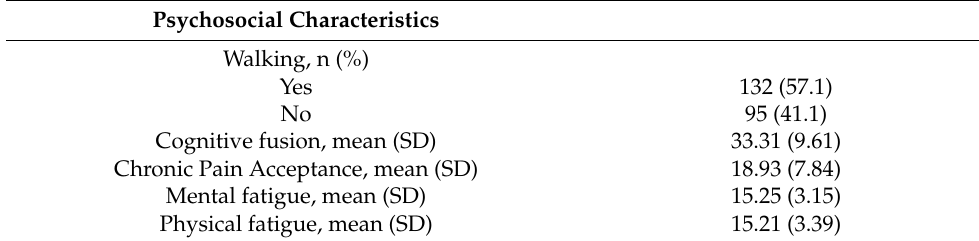
Table 1. Descriptive statistics for psychosocial characteristics ( n =